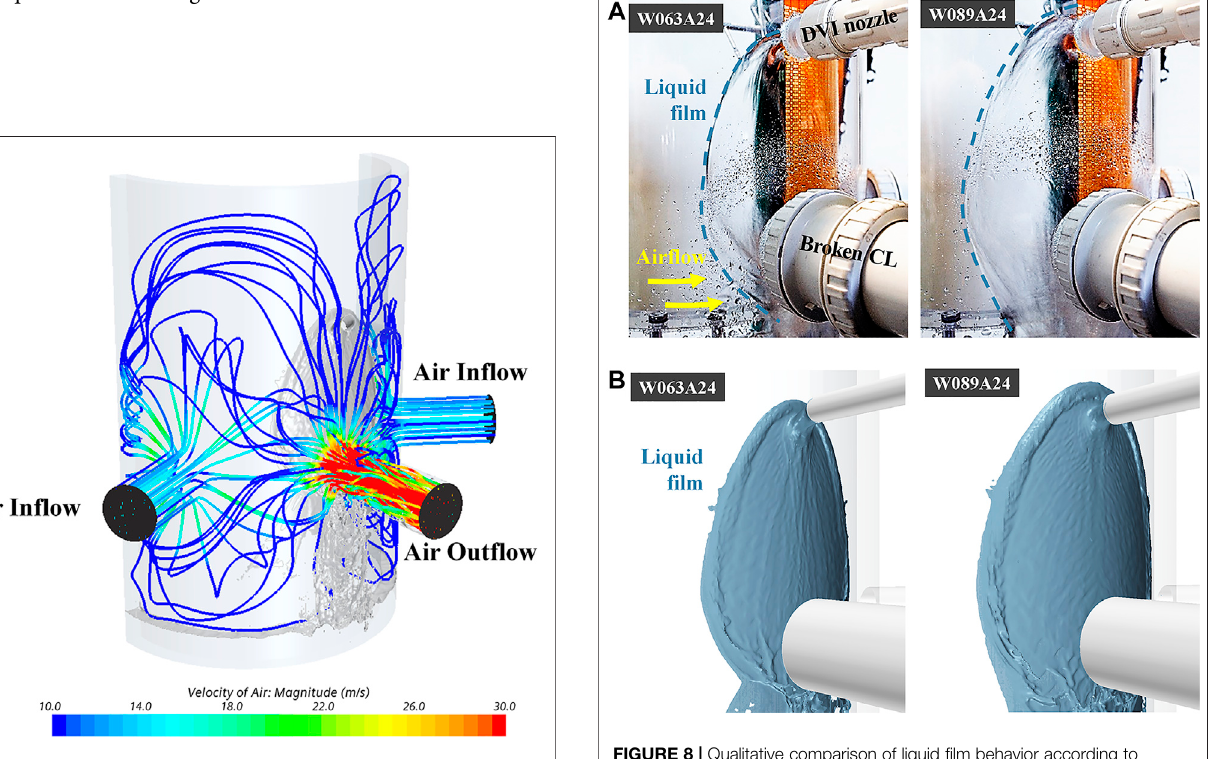
FIGURE 7 | Streamline of air fl ow (W063A26).